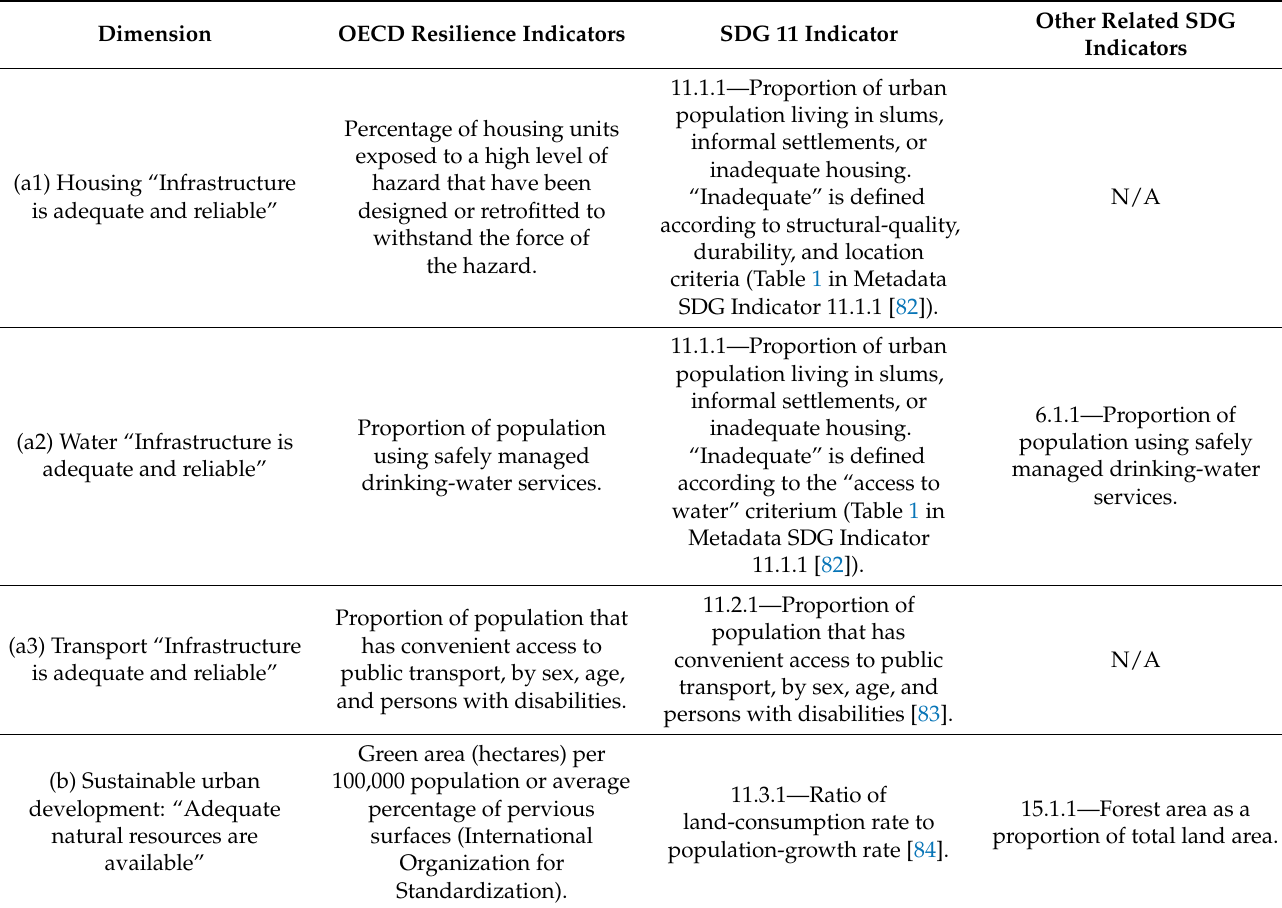
Table 4. OECD and corresponding SDG 11